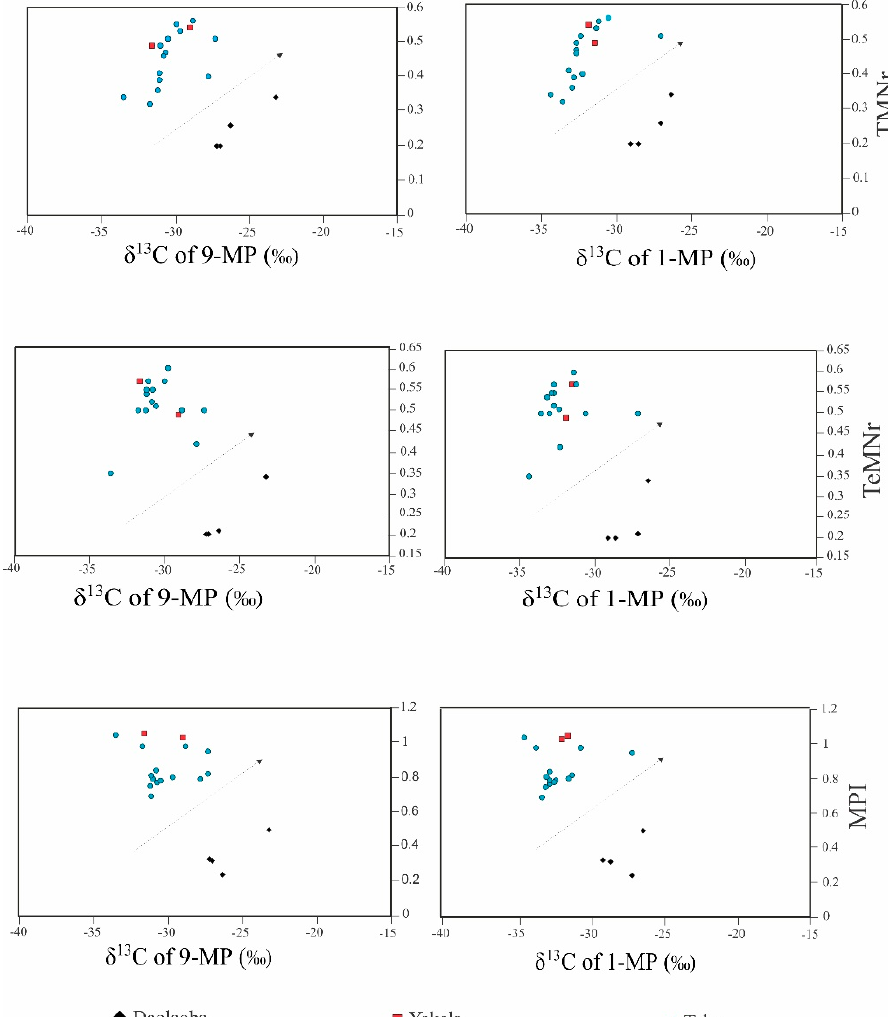
Figure 11. Cross plots of weighted mean δ 13 C values of 9-MP and 1-MP from crude oils’ sub-fractions versus maturity indicator parameters TMNr (1,3,7/1,3,7 + 1,2,5)-TMN, TeMNr (1,3,6,7/1,3,6,7 + (1,2,5,6 + 1,2,3,5))-TeMN and MPI: 1.5 (2-MP + 3-MP)/(P + 1-MP + 9-MP).